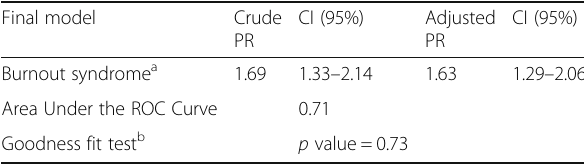
Table 4 Final model of the association between burnout syndrome and abdominal adiposity obtained by multivariate logistic